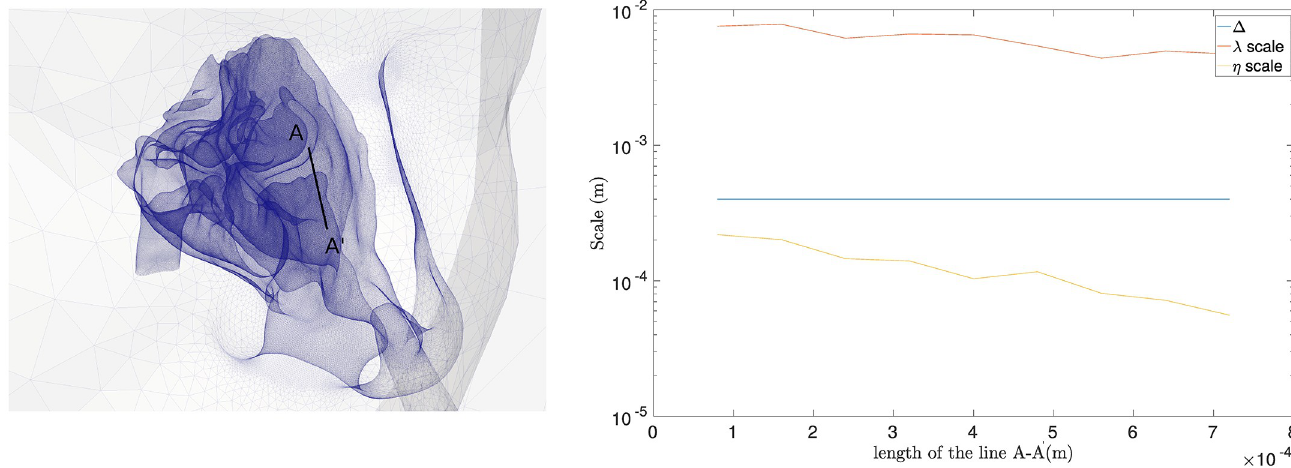
Fig 7. Comparison of different turbulence scales (M2 mesh and Q max = 57.4 L / min ) on the most critical region (downstream of nasal valve).